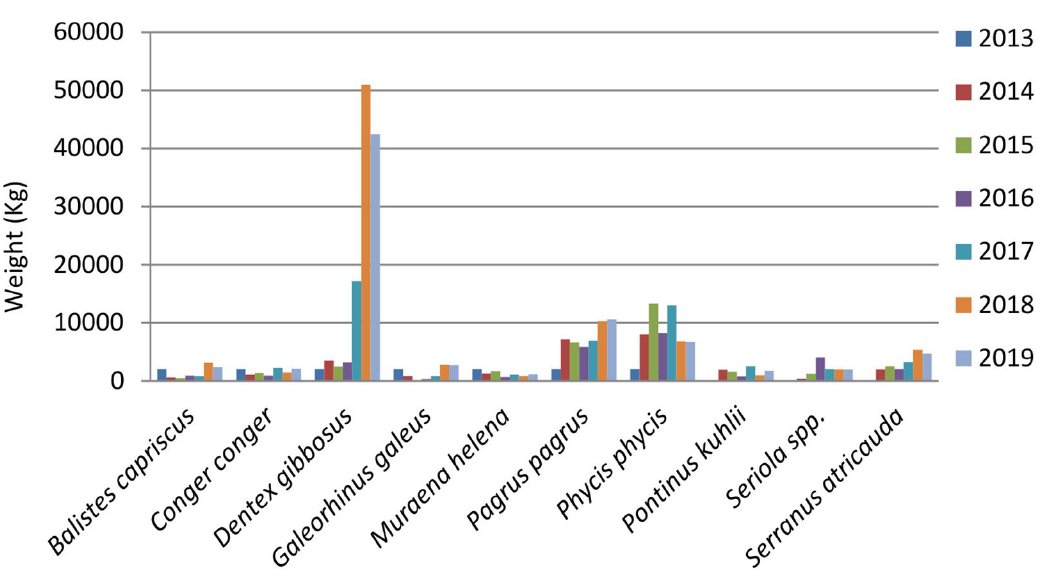
Fig. 3. – Landings (weight) of the most captured species by artisanal fishery and their evolution along the years